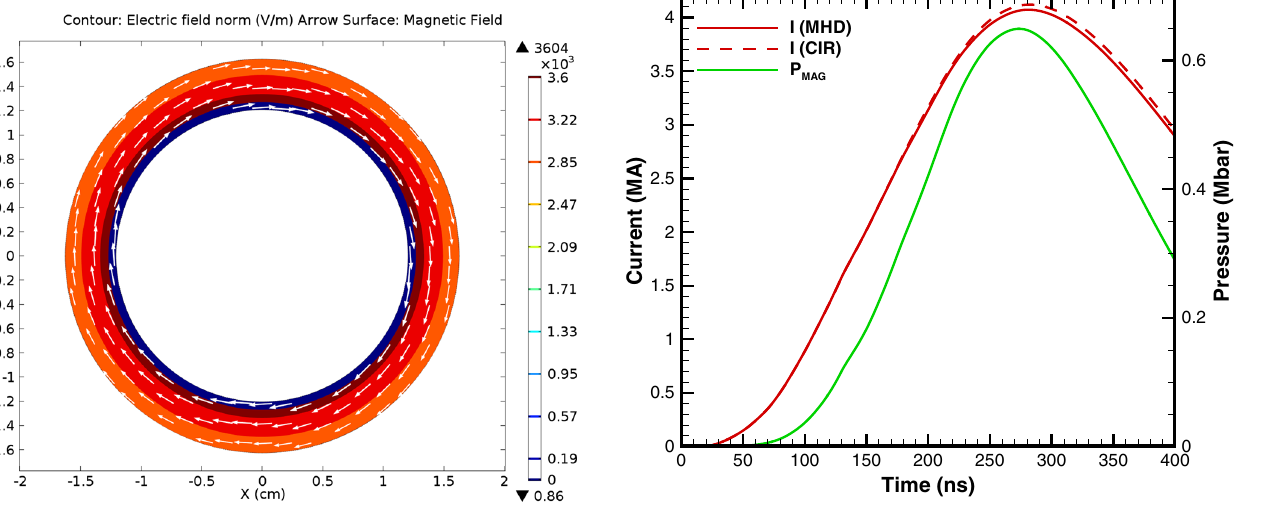
FIG. 11. Radio-frequency calculation of the electromagnetic fields in a cross section of coaxial cable. White lines are magnetic field vectors. Contours are electric fields.